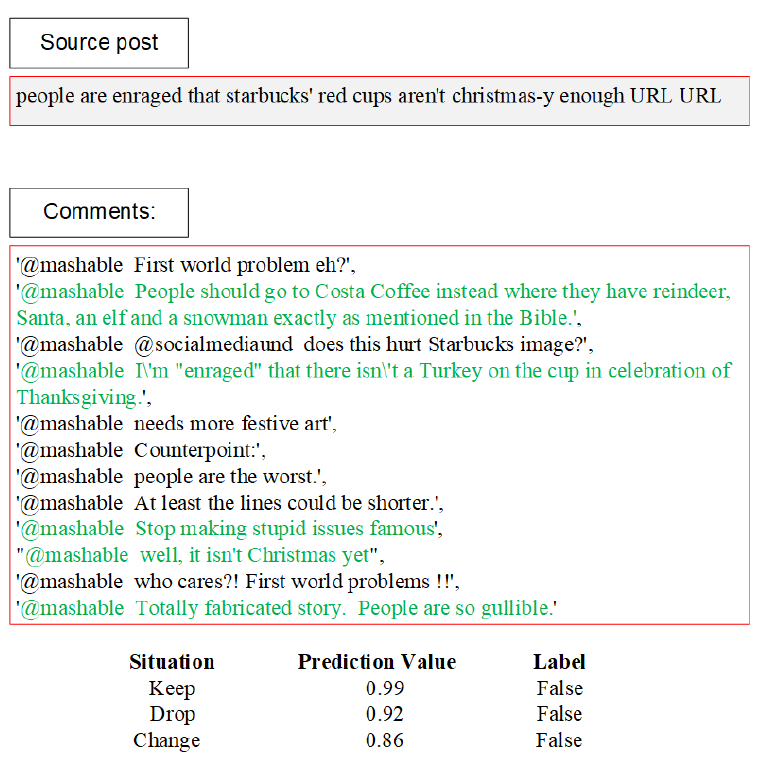
Figure 4. The case study of interpretability on sentence-level co-attention. The green sentences are selected comments, and it also shows the value of prediction under different